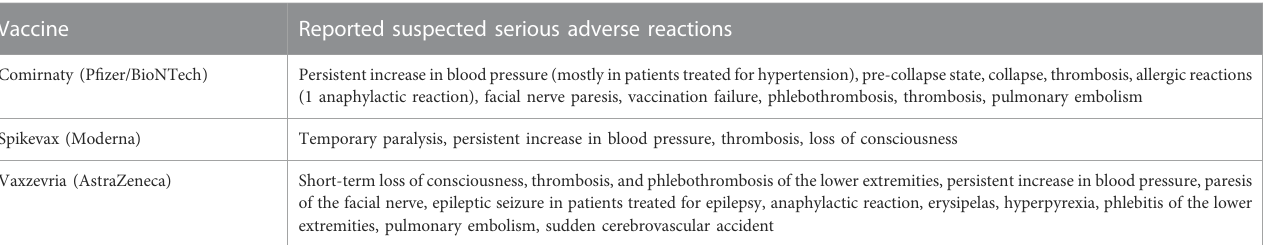
TABLE 3 The most frequently reported suspicions of serious adverse reactions after the administration of vaccines for the prevention of COVID-19 until 31 May 2021.